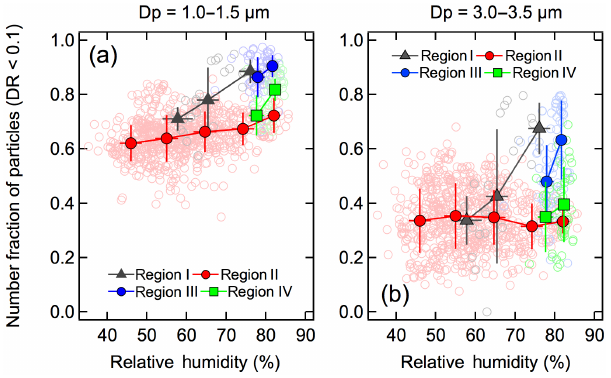
Figure 8. Scatter plots of the dependence of the number fraction of particles (DR < 0.1) as a function of relative humidity for different size ranges (a) 1.0–1.5µm and (b) 3.0–3.5µm. The light-colored circles in the background of the plot are the original data used for performing the statistical